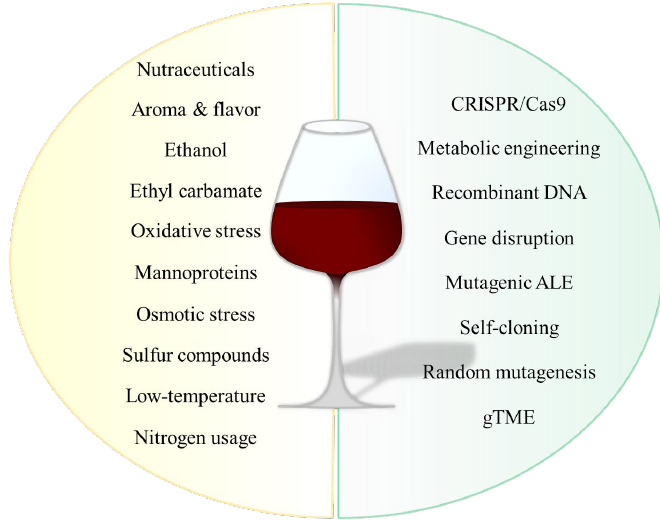
Figure 2. Genetic engineering of winemaking using S. cerevisiae as a tool and producer organism. On the left, the main traits targeted; on the right, the main genetic engineering techniques employed for this end.